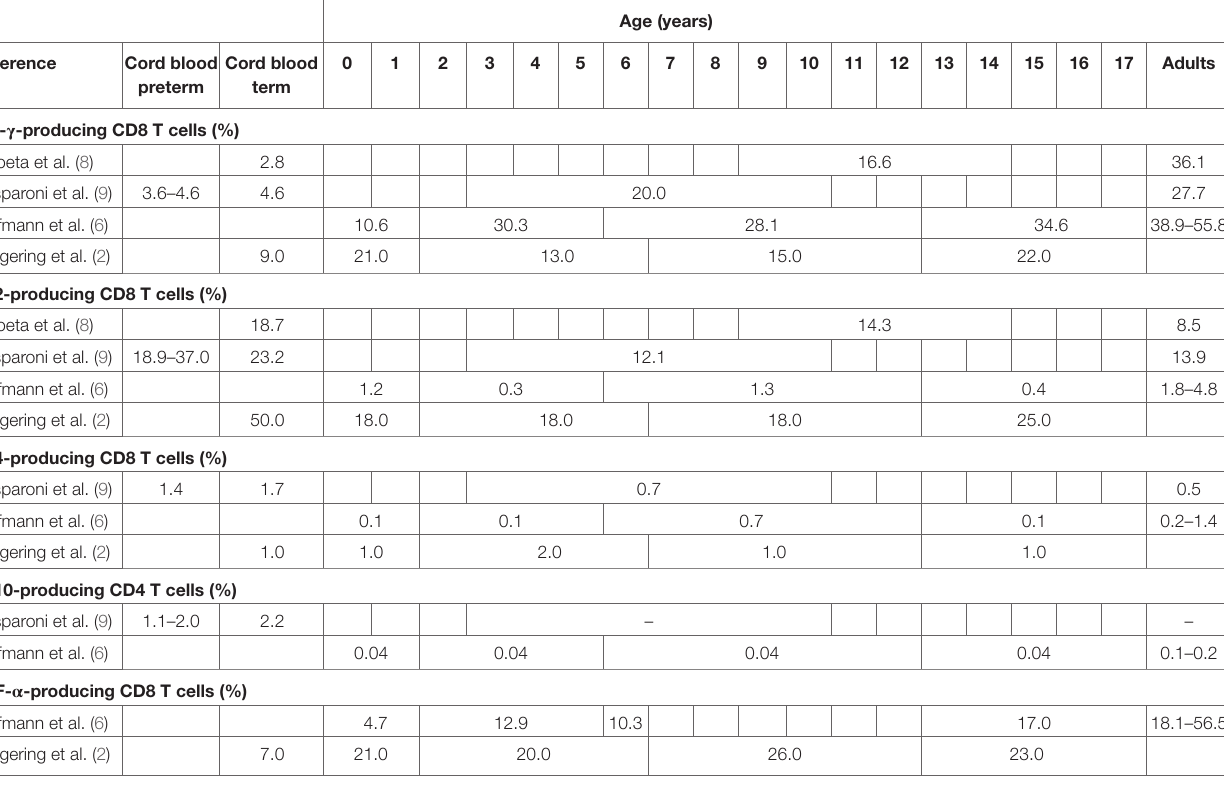
taBLe 3 | Proportions of cytokine-producing cells in stimulated CD8 T cells from healthy neonates and children (flow cytometry